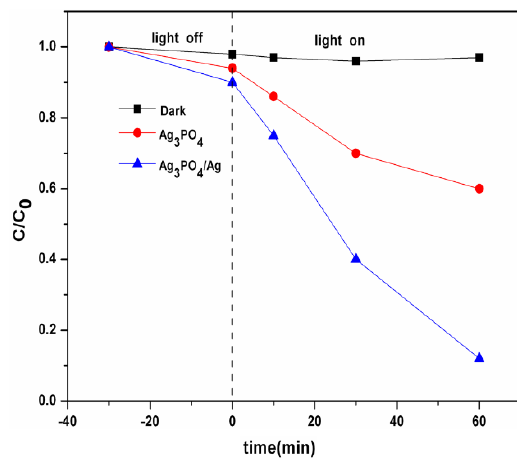
Figure 5. Photocatalytic activities of Ag pure Ag PO particles for RhB degradation under visible-light 3 4 irradiation (λ> 420 nm).